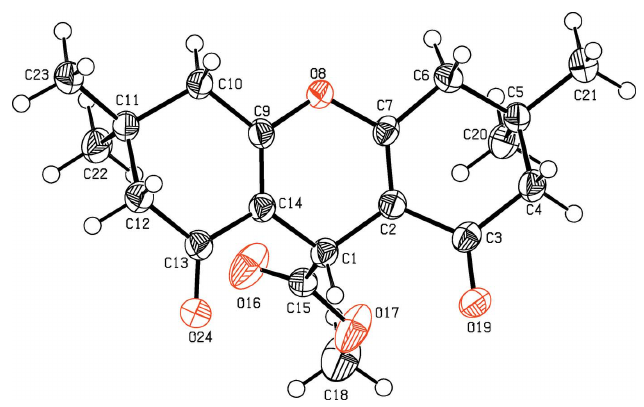
Figure 1 Perspective view of the title compound. Displacement ellipsoids are drawn at the 50% probability